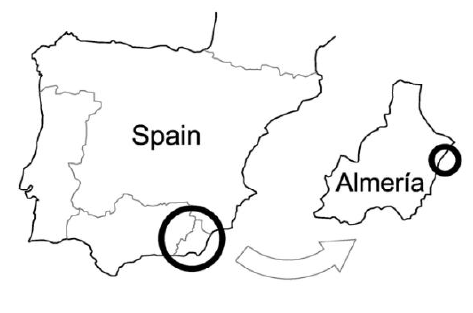
Figure 1. Location of the working area.